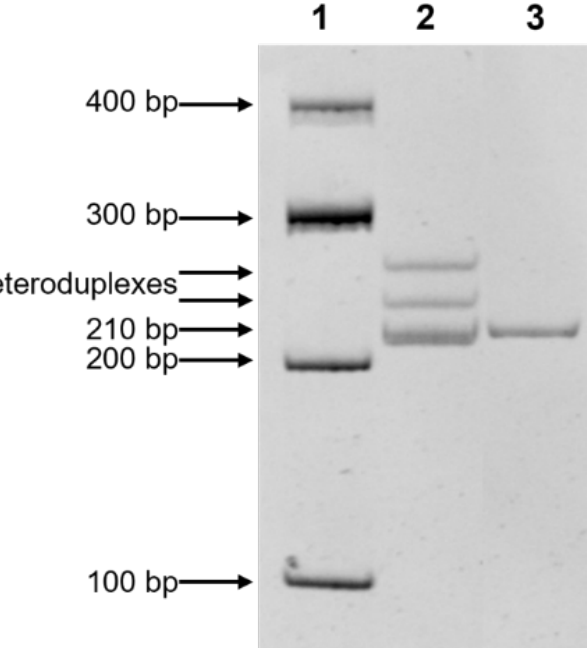
Figure 3. Electrophoregram of PCR-based test system for population screening for c.1659_1660del nucleotide variant in COL6A2 gene. Lanes: 1—100 bp DNA Ladder; 2—heteroduplexes indicate a heterozygous state (WT/mut); 3—WT/WT (210 bp).